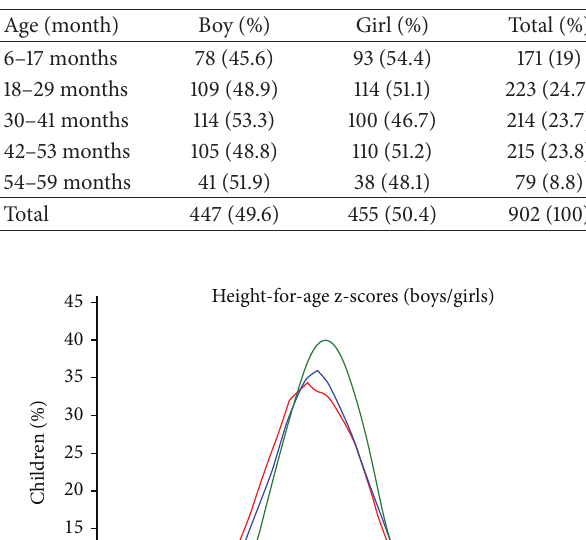
Table 1: Characterize of children 6–59 months in Salmas 2011.